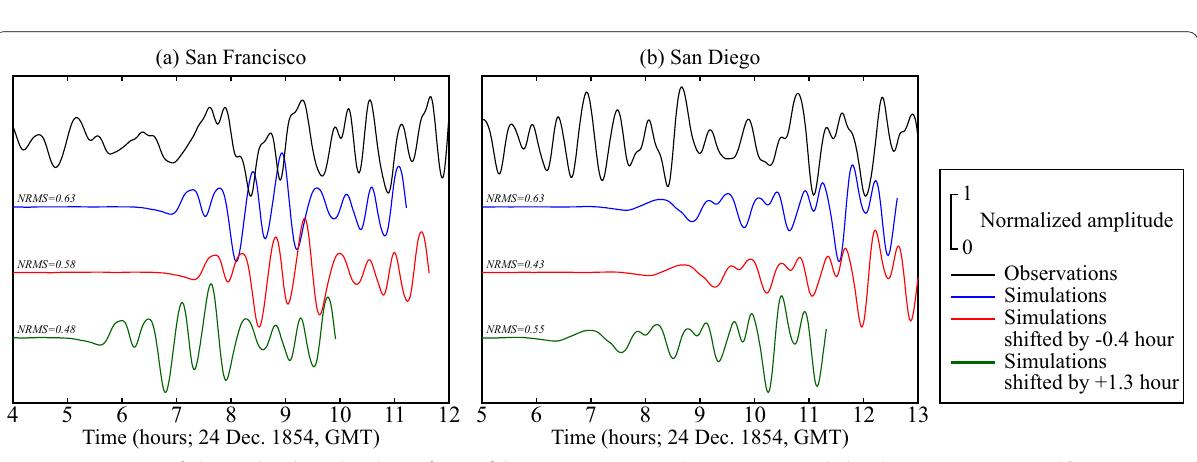
0.4 h and 1.3 h, − +